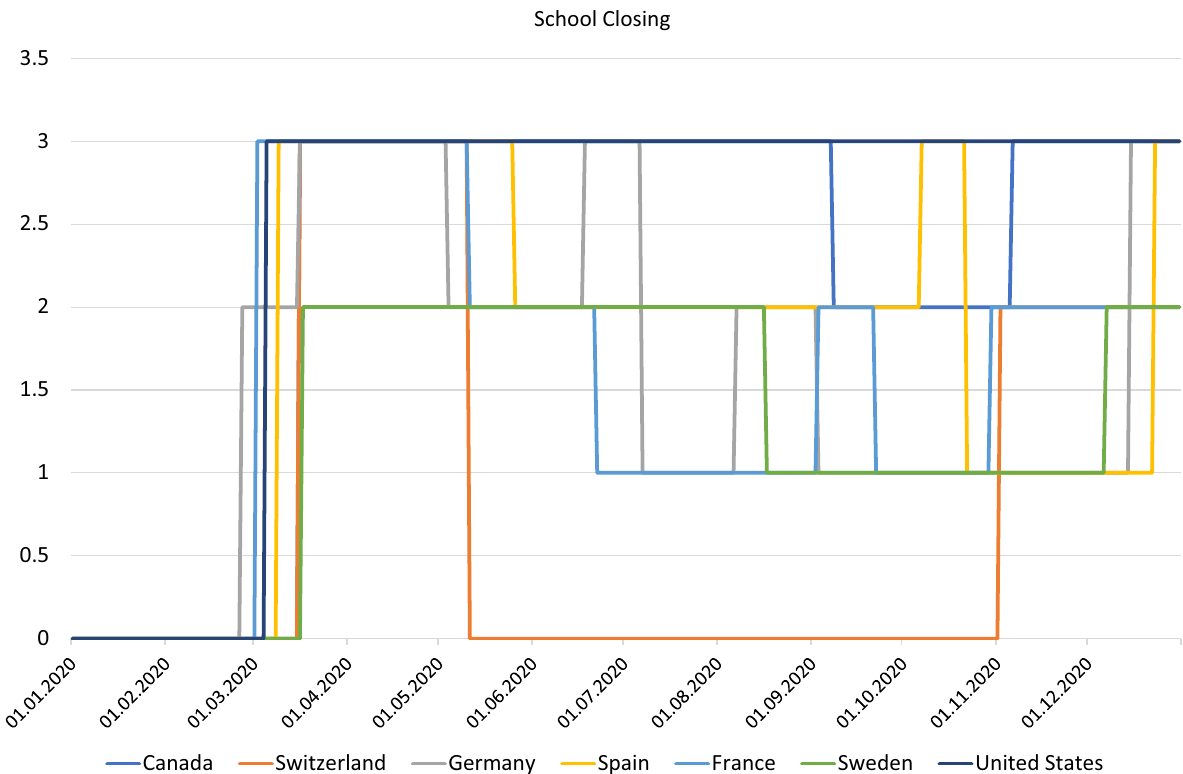
Fig. 11 School closure index. Notes The index records the stringency of school closure policy in several developed economies. The values range from 0 ( no measures) to 3 ( closing all levels). Source = =